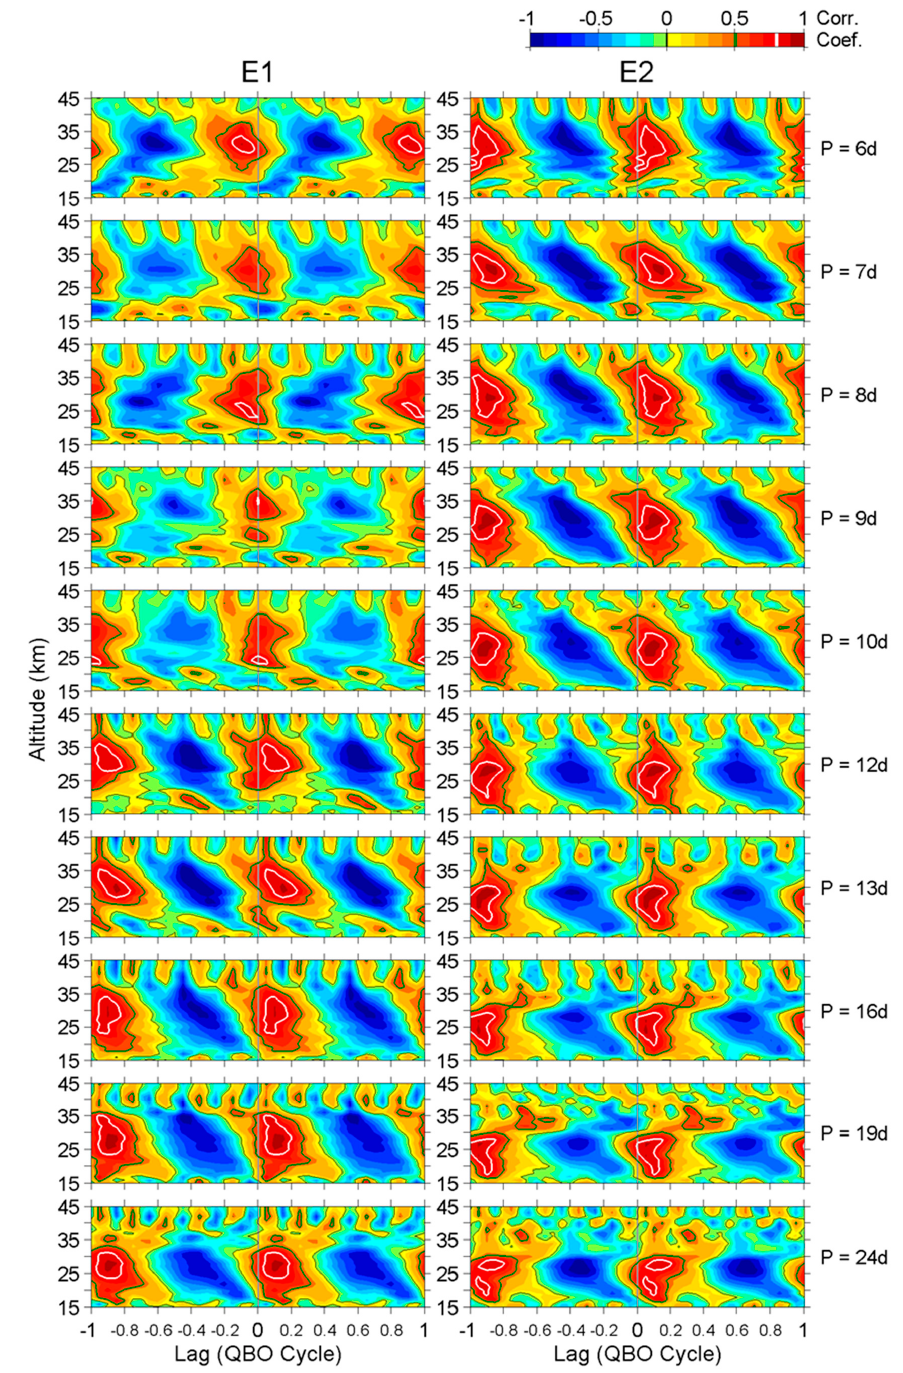
Figure 8. The linear cross correlation coe ffi cients between the time-averaged wave amplitudes and the acceleration of zonal wind in a layout that is similar to Figure 7. Black, green, and white lines circle regions where the correlation coe ffi cient is greater than 0, 0.5, and 0.8, respectively. Gray lines indicate zero